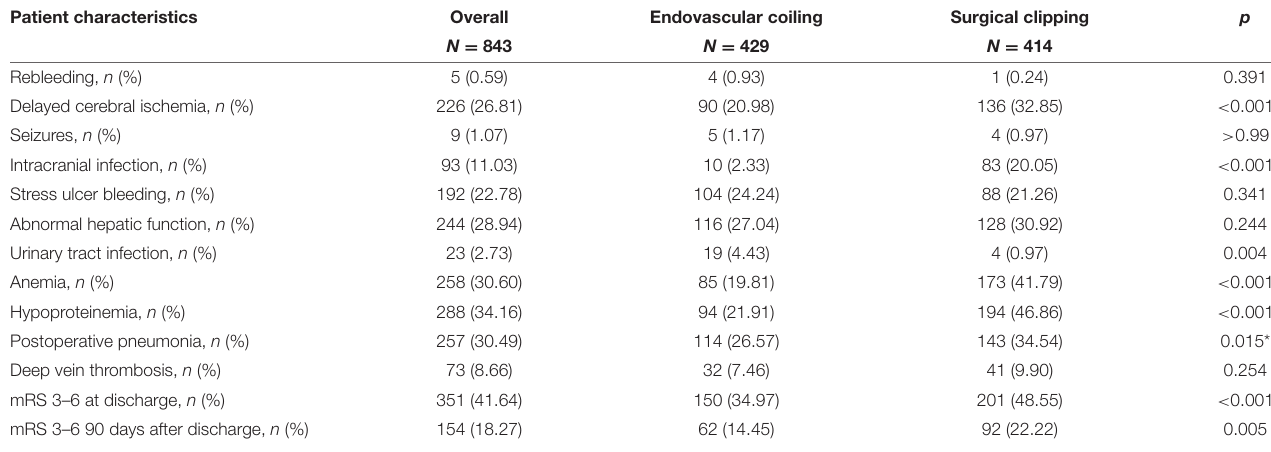
TABLE 2 | The comparison of in-hospital complications between two treatment modalities. Patient